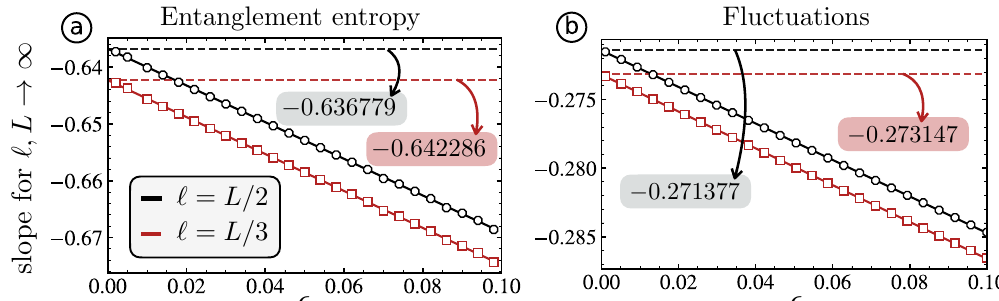
Figure 4: a (cid:13) The slope of the entanglement entropy differences δ S ( λ ) fitted in the window λ = ( 1 − ε ) ...1 and extrapolated to the limit (cid:96) , L → ∞ for (cid:96) = L / 2 (black circles) and (cid:96) = L / 3 (red squares). In the limit ε → 0, the slope is given by the analytically predicted value Eq. (59), here shown by horizontal dashed lines. b